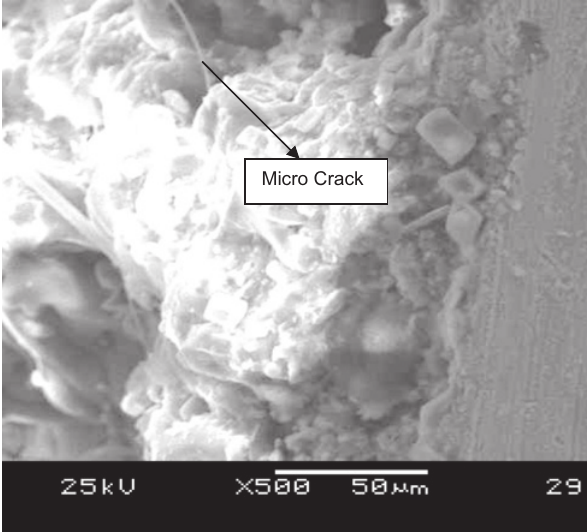
Figure 7: SEM micrograph showing the formation of cracks in the mixed oxide